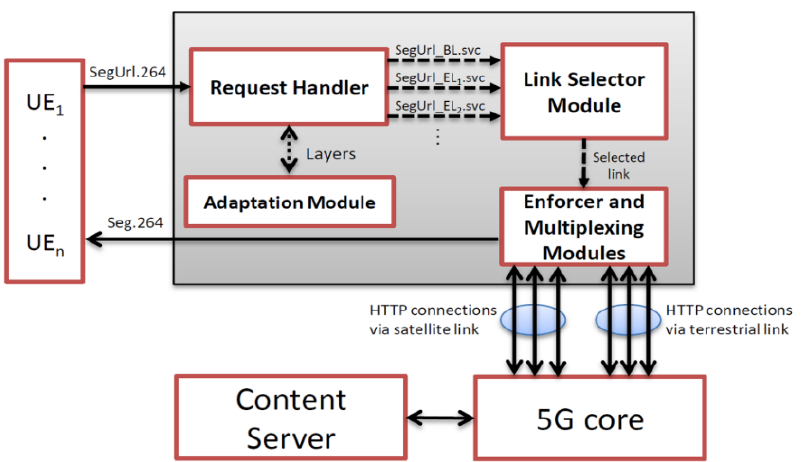
Figure 9. SaT5G Architecture for Use Case 2: Multiclient video streaming with multilinking testbed